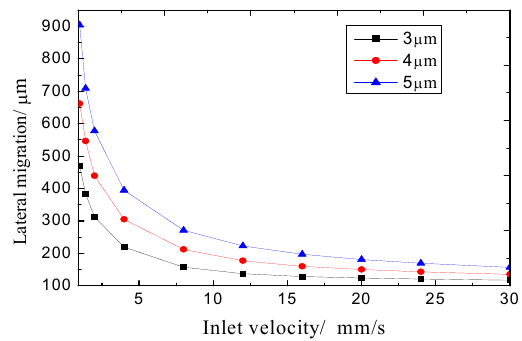
Figure 8. Lateral migrations of micro-particles with various inlet velocities.